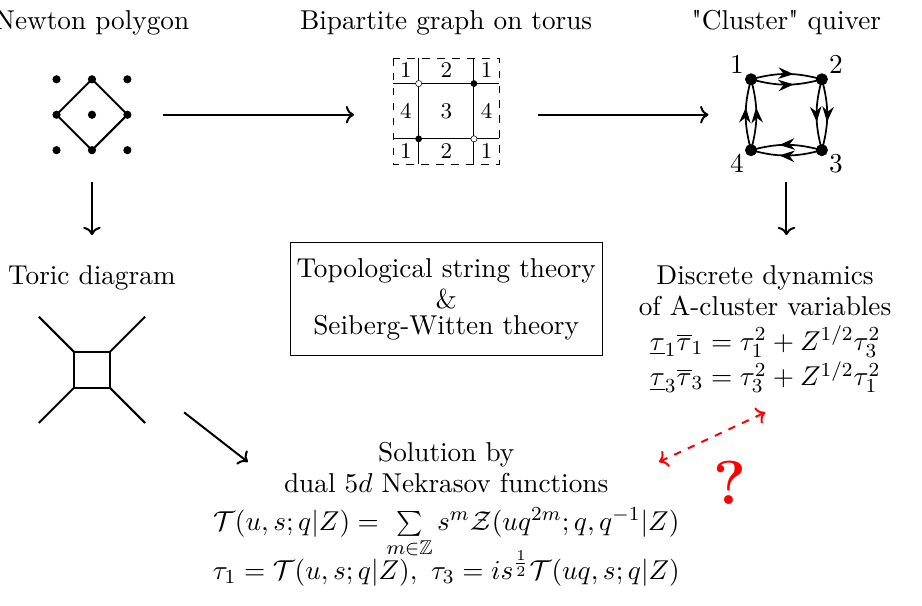
Figure 1 . The long way between the q -difference equations and their